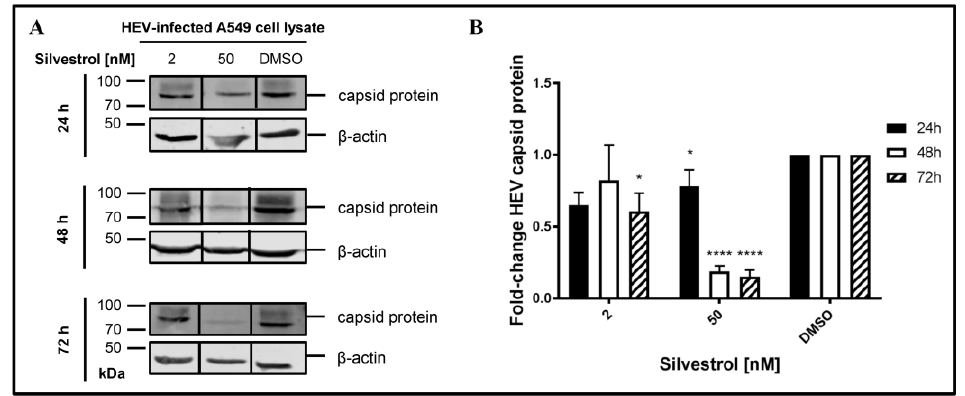
Figure 4. Effects of silvestrol on intracellular HEV capsid protein levels in A549 cells persistently infected with HEV strain 47832c. ( A ) Representative Western Blot of cellular lysates derived from cells treated with either 2 nM or 50 nM silvestrol. DMSO treatment served as control. For detection, a capsid protein specific antiserum and a beta-actin-specific antibody (loading control) were used; ( B ) Relative quantification of Western Blot band intensities normalized to intracellular beta-actin levels referred to the DMSO control. n = 3; * p < 0.05, **** p < 0.0001.